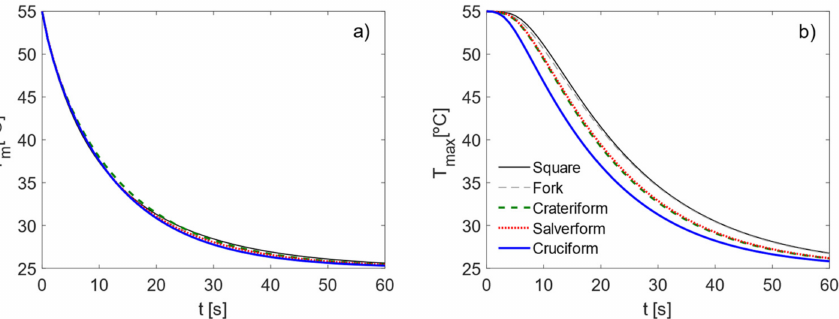
Figure 6. Time evolution of the ( a ) average and ( b ) maximum temperature of the plate for all